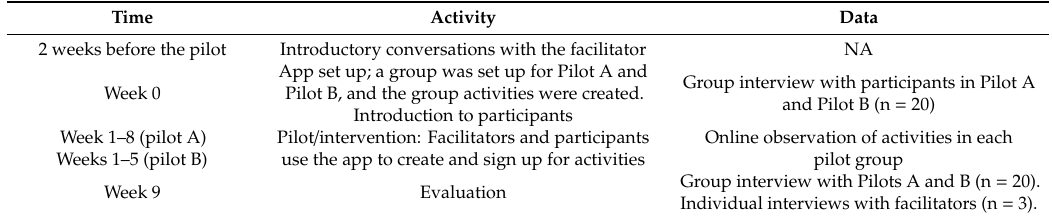
Table 2. Activities and